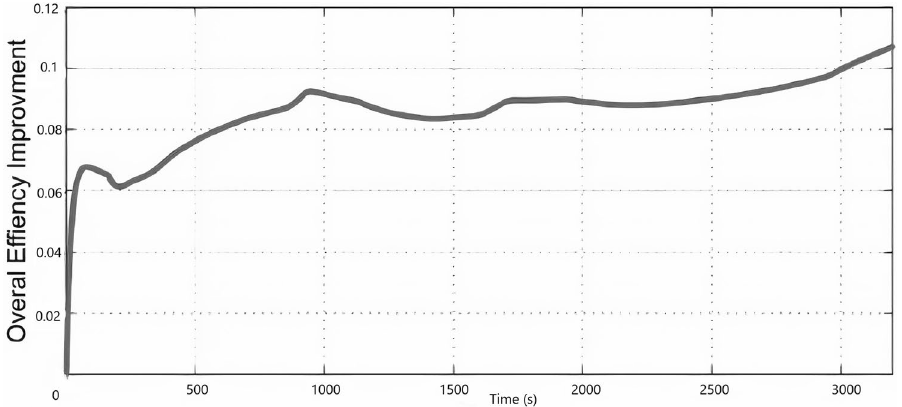
Fig. 19 The effect of TPV on overall heat efficiency